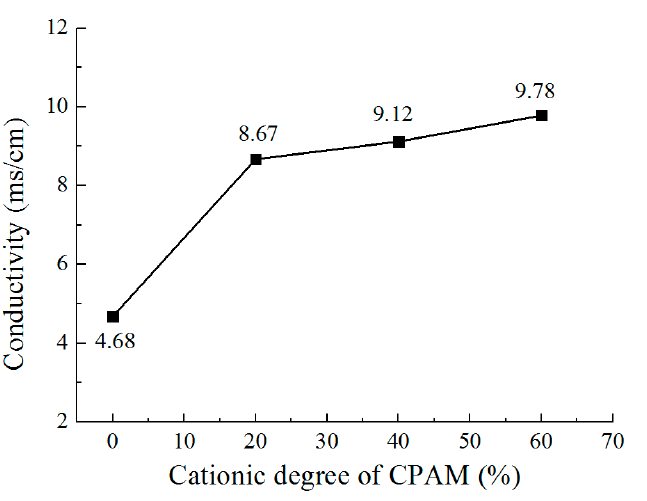
Figure 3. Conductivity of CPAM–electrolyte with different cationic degrees.